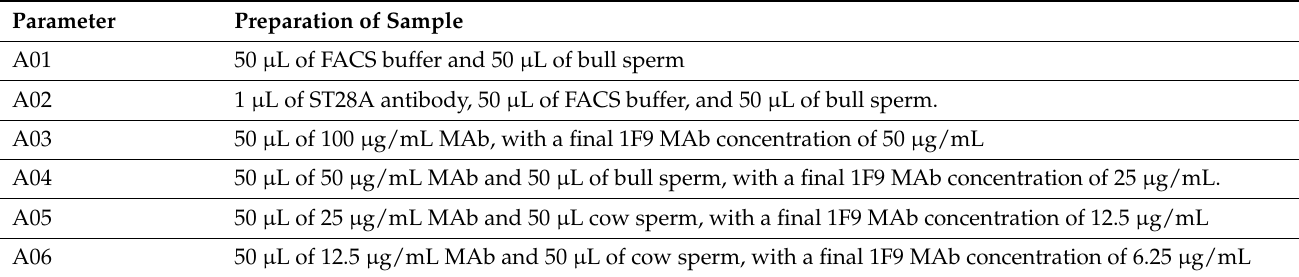
Table 2. Parameter of sample A01–A06 was prepared for analyzed using flow